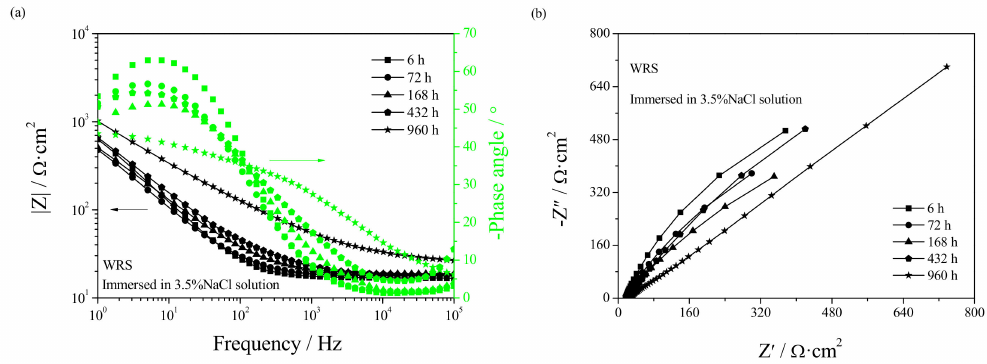
Figure 13. Bode ( a ) and Nyquist ( b ) plot of WRS immersed at di ff erent times in 3.5% NaCl solution.